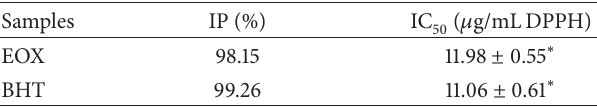
Table 2: Radical scavenging activity of X. laevigata leaf essential oil (EOX) determined by the reduction of DPPH free